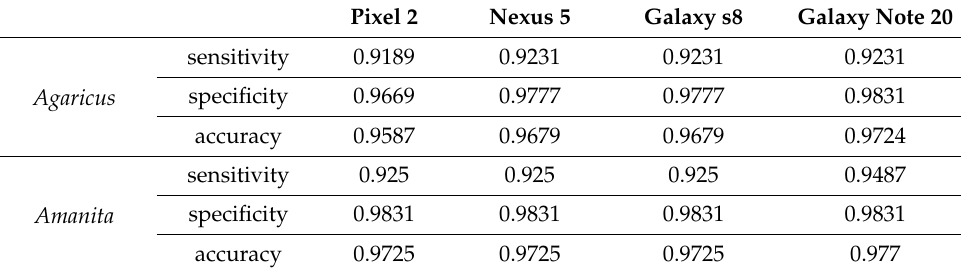
Table 4. Inter-phone testing results—5